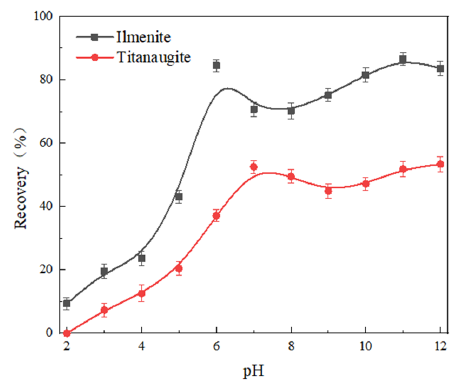
Figure 4. Effect of pH on flotation recovery of ilmentie and titanaugite treated with sodium oleate (the mineral size distributions of 38–74 µ m, 2.0 × 10 − 4 mol · L − 1 sodium